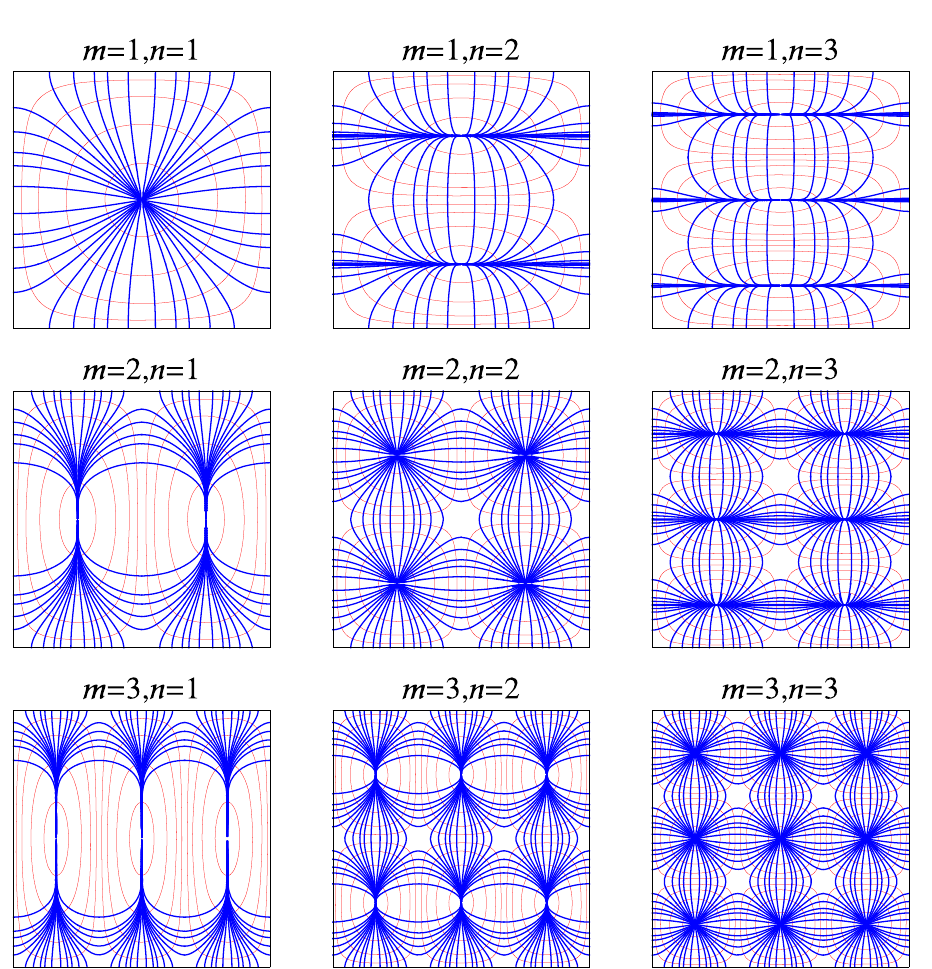
Figure 4. Electric field patterns (blue lines) and their corresponding cross sections of equipotential surfaces (red lines) for the first nine electrostatic modes of a square waveguide ( h with an anisotropic medium, for example a medium of nanowire-based